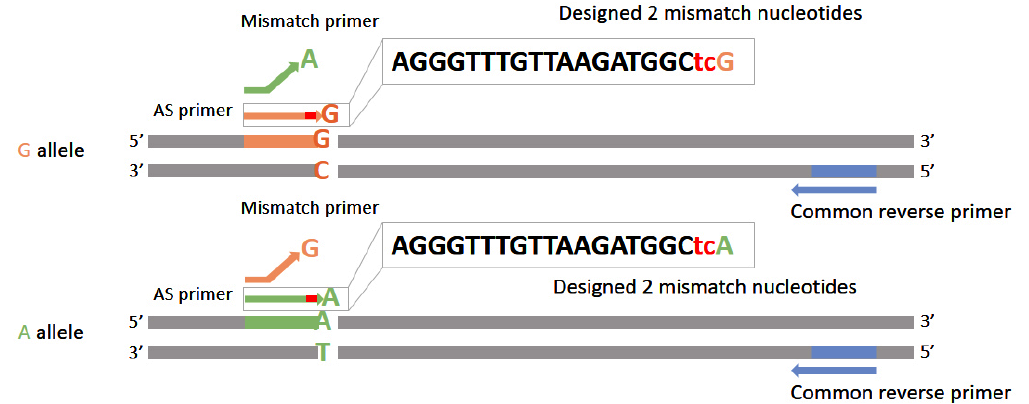
Figure 4. The design of primers in ARMS-qPCR. A set of primers in ARMS is composed of 3 primers, including one common revers primer (blue) and two allele-specific (AS) forward primers (orange and green). The last base of AS primers are set purposively to be consistent with altered bases, while the two nucleotides immediately 5’ to the mutated site (marked as red) are also changed to increase the resolving power of ARMS.